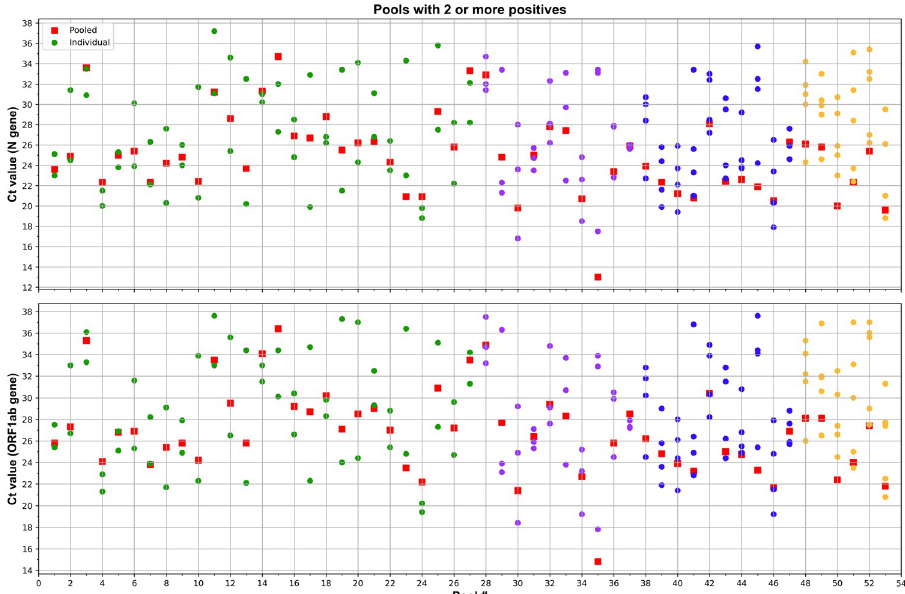
Fig 3. Pools with two or more positives. Scatter plots showing Ct values detected by rRT-PCR in five-samples pools (squares) and the individual positive samples (circles) from pools containing 2 (Pool # 1–27), 3 (Pool # 28–37), 4 (Pool # 38–47) or 5 (Pool # 39–53) positive samples. The analysis was performed for N (top graph) and ORF1ab (bottom graph) genes.